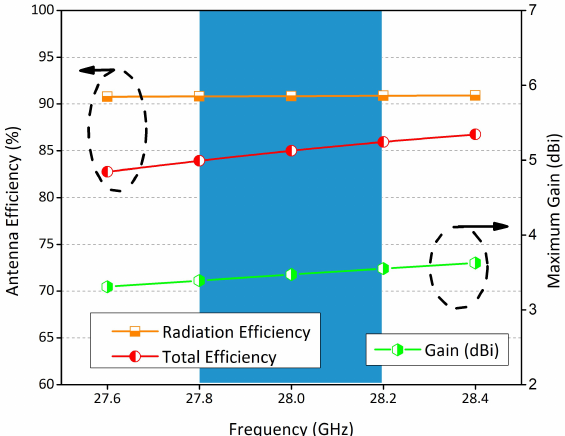
Figure 4. Performance parameters of the proposed